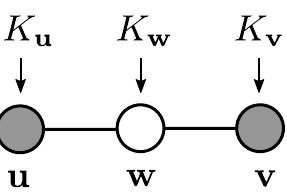
Figure 1 . Dynkin diagram of the SU(4) alternating spin chain. The gray circles are the momentum carrying